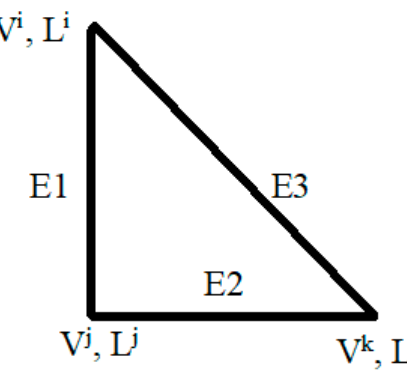
Figure 1. Calculating DFE (cid:48)(cid:48) a from DFN (cid:48)(cid:48) a